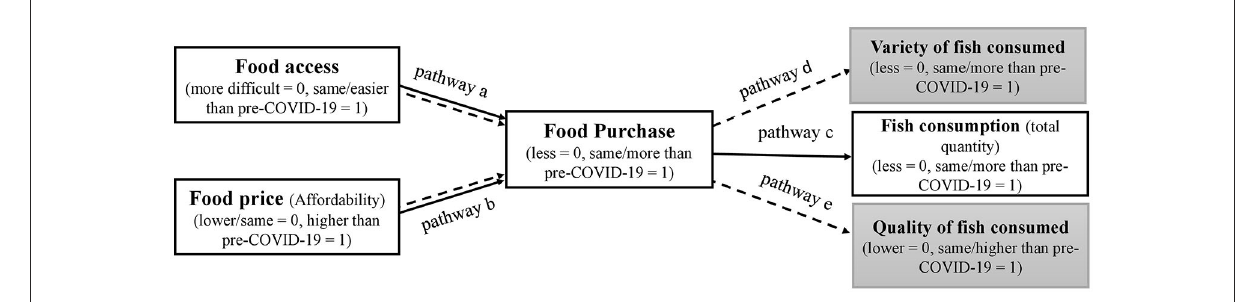
FIGURE1 Diagram showing hypothesized basic model (solid arrows, pathway a, b, and c) and extended model (dashed arrows, pathway a, b, d, and e).